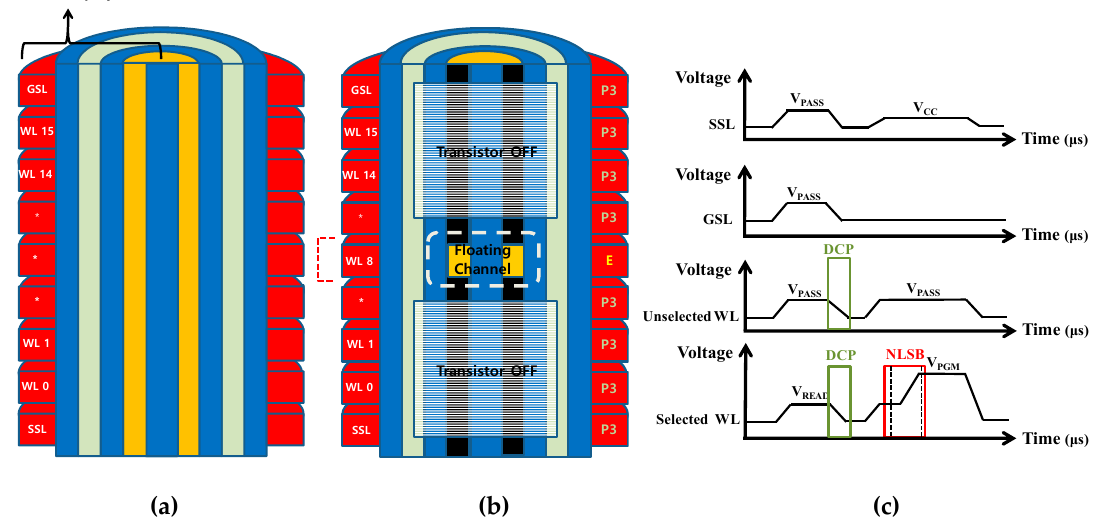
Figure 1. ( a ) Structure of 3D NAND with 16WL, select string line (SSL) and ground string line (GSL) transistors; ( b ) the explanation of channel floating behavior; ( c ) bias timing diagram when NLSB occurs. Table 1. Three-dimensional NAND device parameters, bias condition.